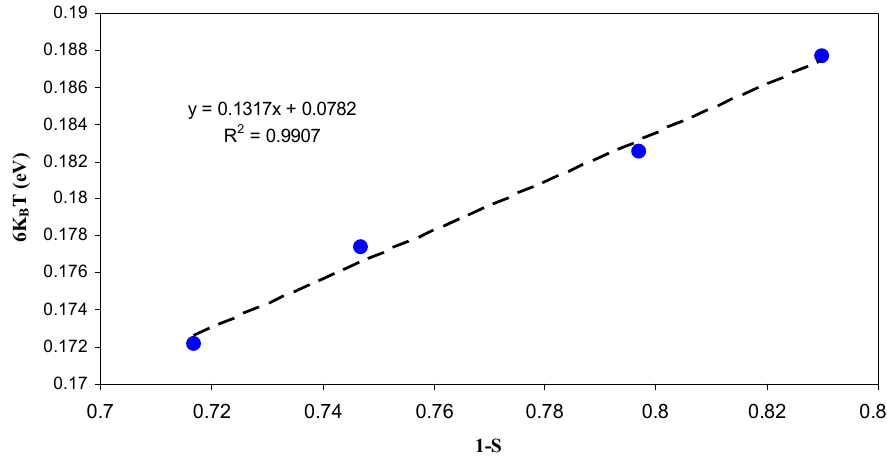
Figure 11. The plot of 6 K B T versus 1 − S for temperature ranges from 333 to 363 K. The W m value is 0.131 eV and is lower than the activation energy ( E a ≈ 0.41 eV) for this temperature range and consequently ions transport obeys the CBH model.